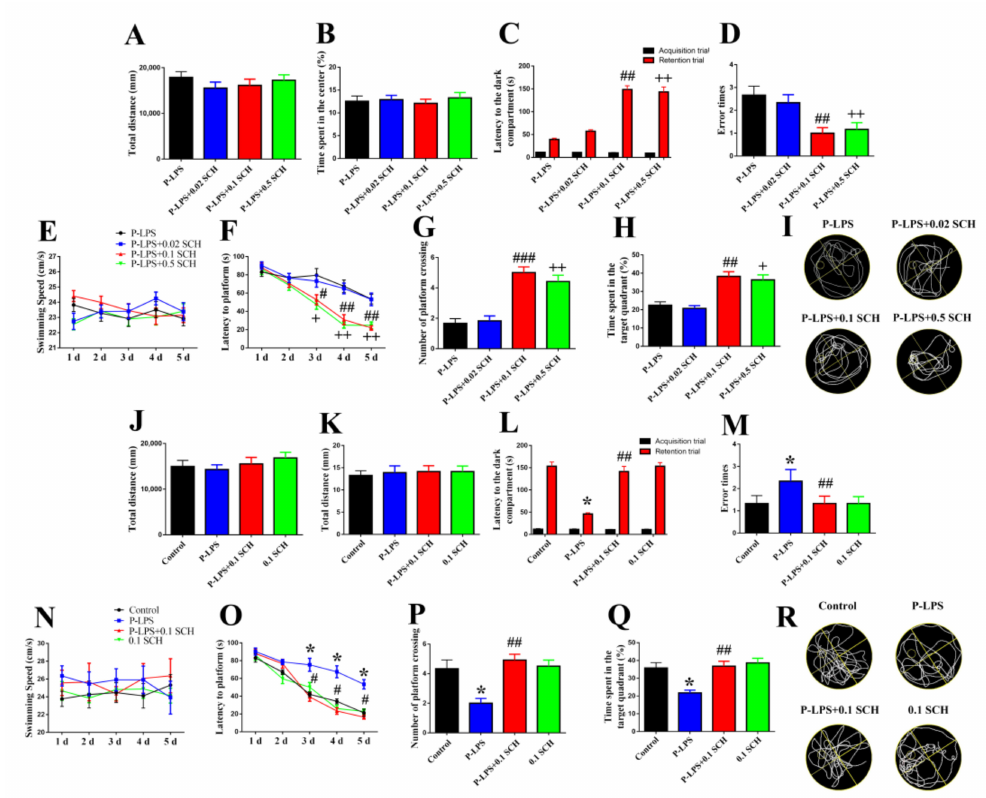
Figure 4. A 2A R antagonist alleviates P. gingivalis LPS-induced learning and memory impaired in mice. Total distance ( A , J ) and time spent in the center ( B , K ) were recorded in the OFT on the day 29 after P. gingivalis LPS. Latency to the dark compartment ( C , L ) and error times ( D , M ) were recorded on the days 36–37 after P. gingivalis LPS. Swimming speed ( E , N ), escape latency ( F , O ), number of platform crossing ( G , P ) and time spent in the target quadrant ( H , Q ) were recorded in the MWM test. ( I , R ) MWM typological trajectories. All data are expressed as the mean ± SEM ( n = 12 per group). * p < 0.05 vs. the control group; # p < 0.05, ## p < 0.01, ### p < 0.001, + p < 0.05 and ++ p < 0.01 vs. the P-LPS